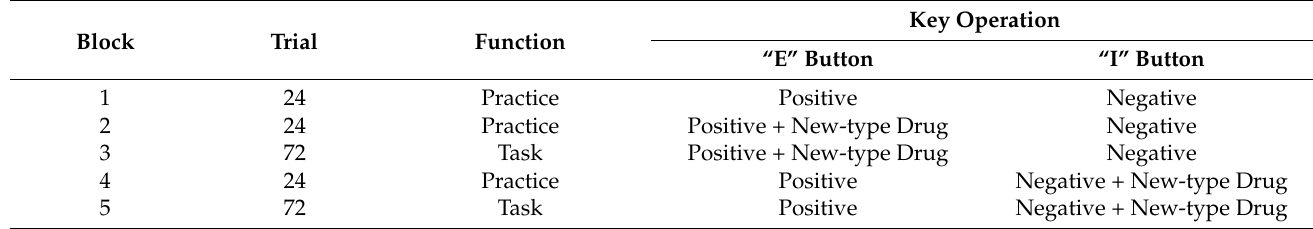
Figure 2. Twelve pictures of negative expressions. Table 1. The experiment procedure of SC-IAT